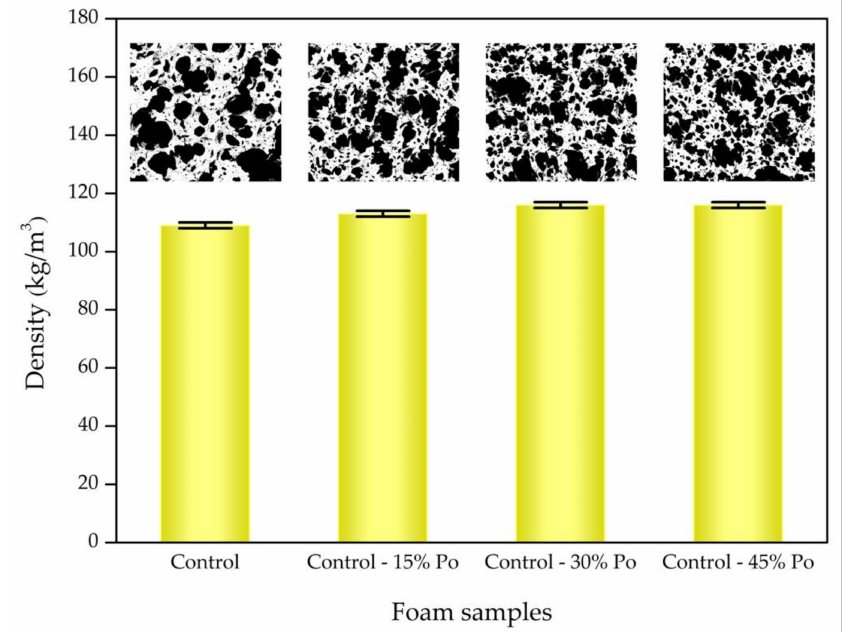
Figure 2. SEM images analysed by ImageJ software and foam density as a function of foam samples with different concentrations of the chemical blowing